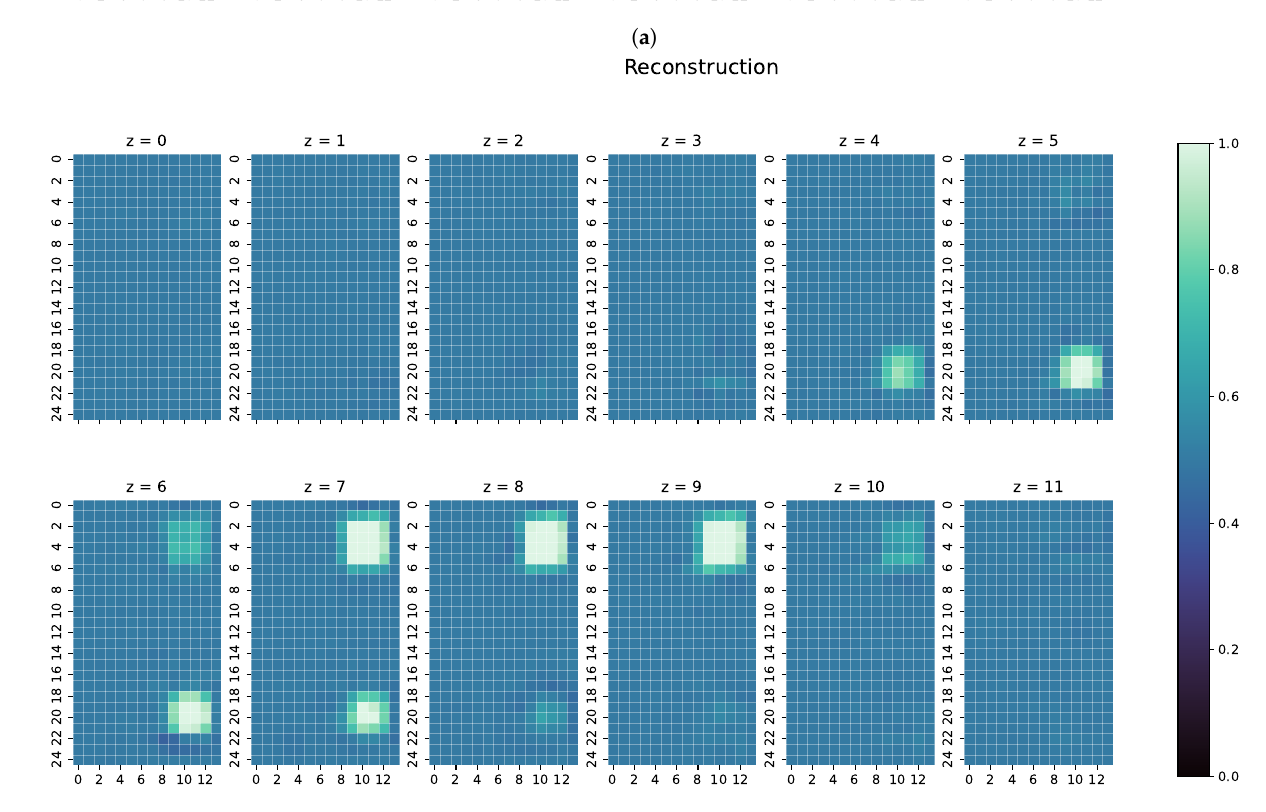
Figure 6. ( a ) Original conductivity distribution for one example from the test dataset. Both perturba- tion objects have a conductivity of 1.0 S/m, which is more difficult to detect than objects with 0.0 S/m because of the lower resulting signals. ( b ) Reconstruction of the conductivtity distribution, as shown in ( a